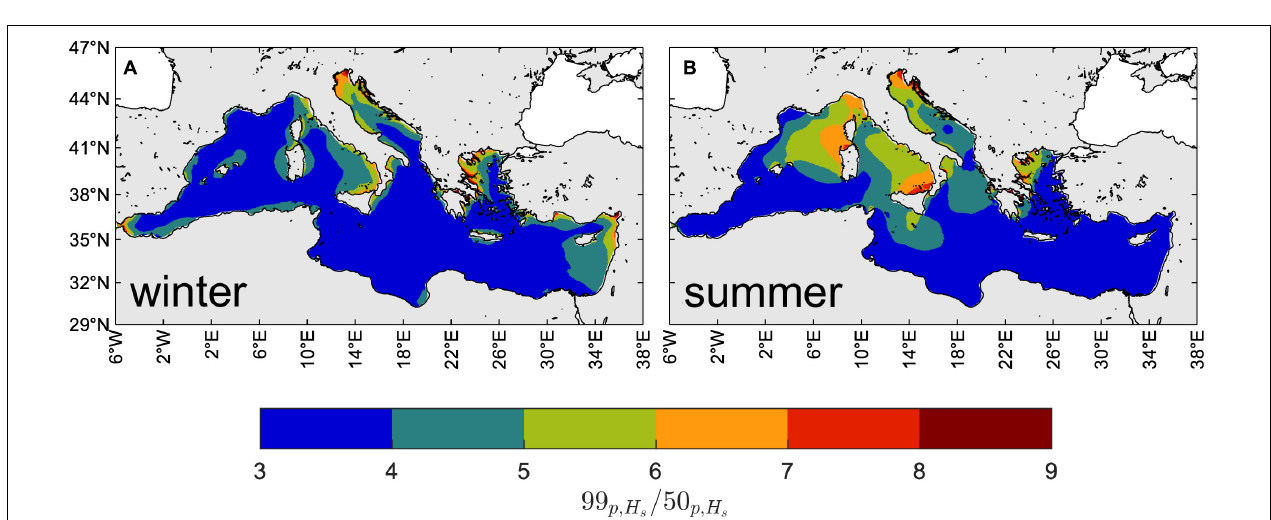
FIGURE 6 | Intra-seasonal variability of the wind-wave climate. Yearly-averaged ratio of the 99th to 50th percentile of H s (1981–2019), during winter [NDJFM, panel (A) ] and summer [JJA, panel (B) ].